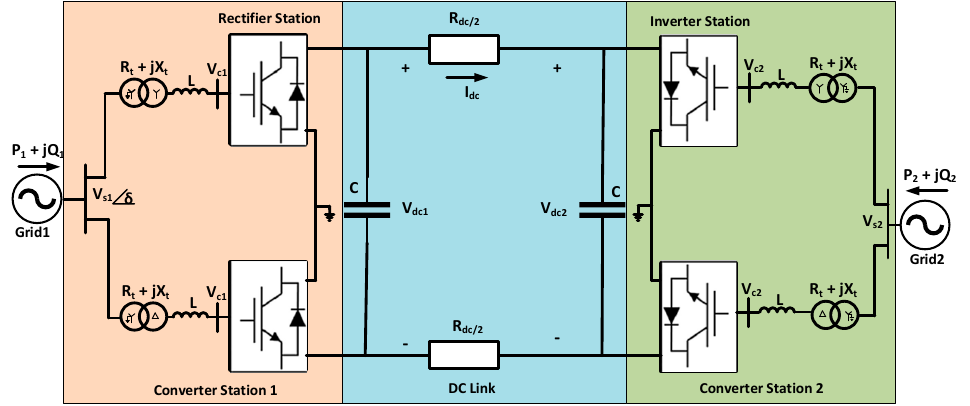
Figure 1. Bidirectional voltage source converter (VSC)-based HVDC light system.